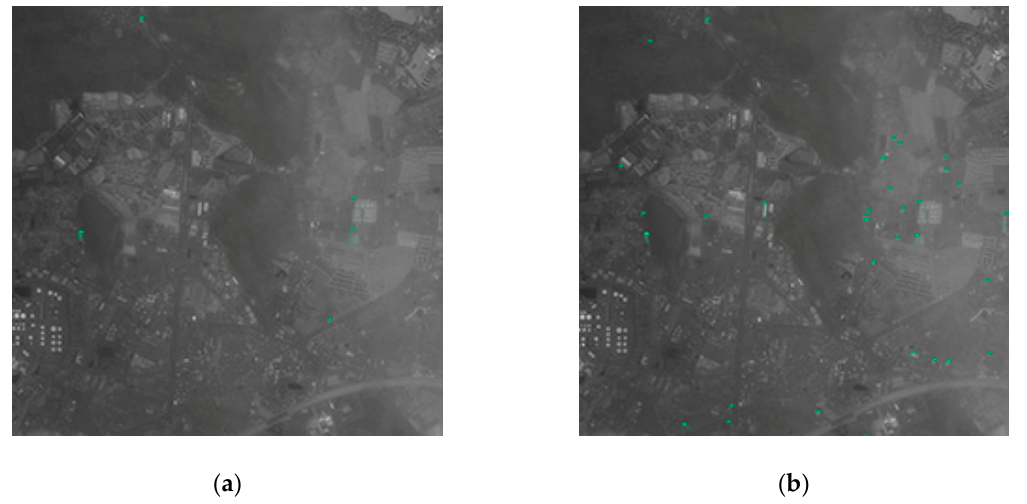
Figure 11. The detection results of the partial region of the GF-2(2) image. ( a ) Test results using network with a proportion of positive to negative samples of 1:1. ( b ) Test results using network with a proportion of positive to negative samples of 1:0.